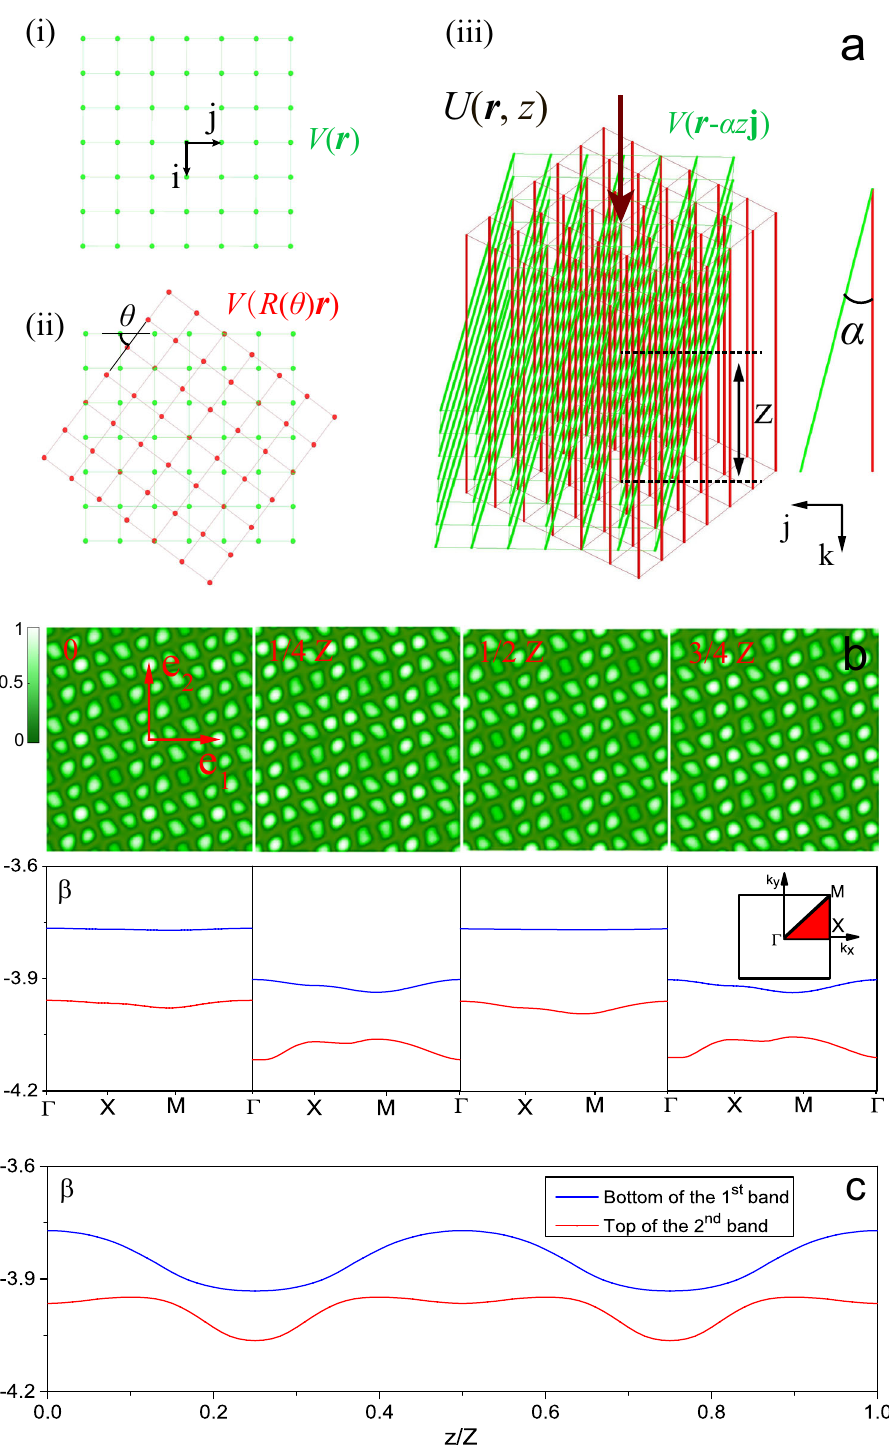
Fig. 1 | Tilted moiré lattices. a Schematics of the tilted moiré lattice based on a reference square lattice V ( r ) with primitive translation vectors a i and a j , where a is thelatticeconstant(heresetto1)(i).Oneoftheconstitutivesublatticesisobtained by twisting the reference lattice by the angle θ around the z -axis, yielding the potential V ( R ( θ ) r ) (the red-colored lattice in(ii)). The second sublatticeis obtained by rotating the reference lattice by an angle α around the x -axis (the olive-colored latticein(iii)),thusproducingthepotential V ( r − α z j ).Superimposing V ( r − α z j )and V ( R ( θ ) r ) results in the moiré potential U shown in (iii). The tilted moiré lattice has a period Z along the direction of the incident beam (shown by a dark-red arrow).